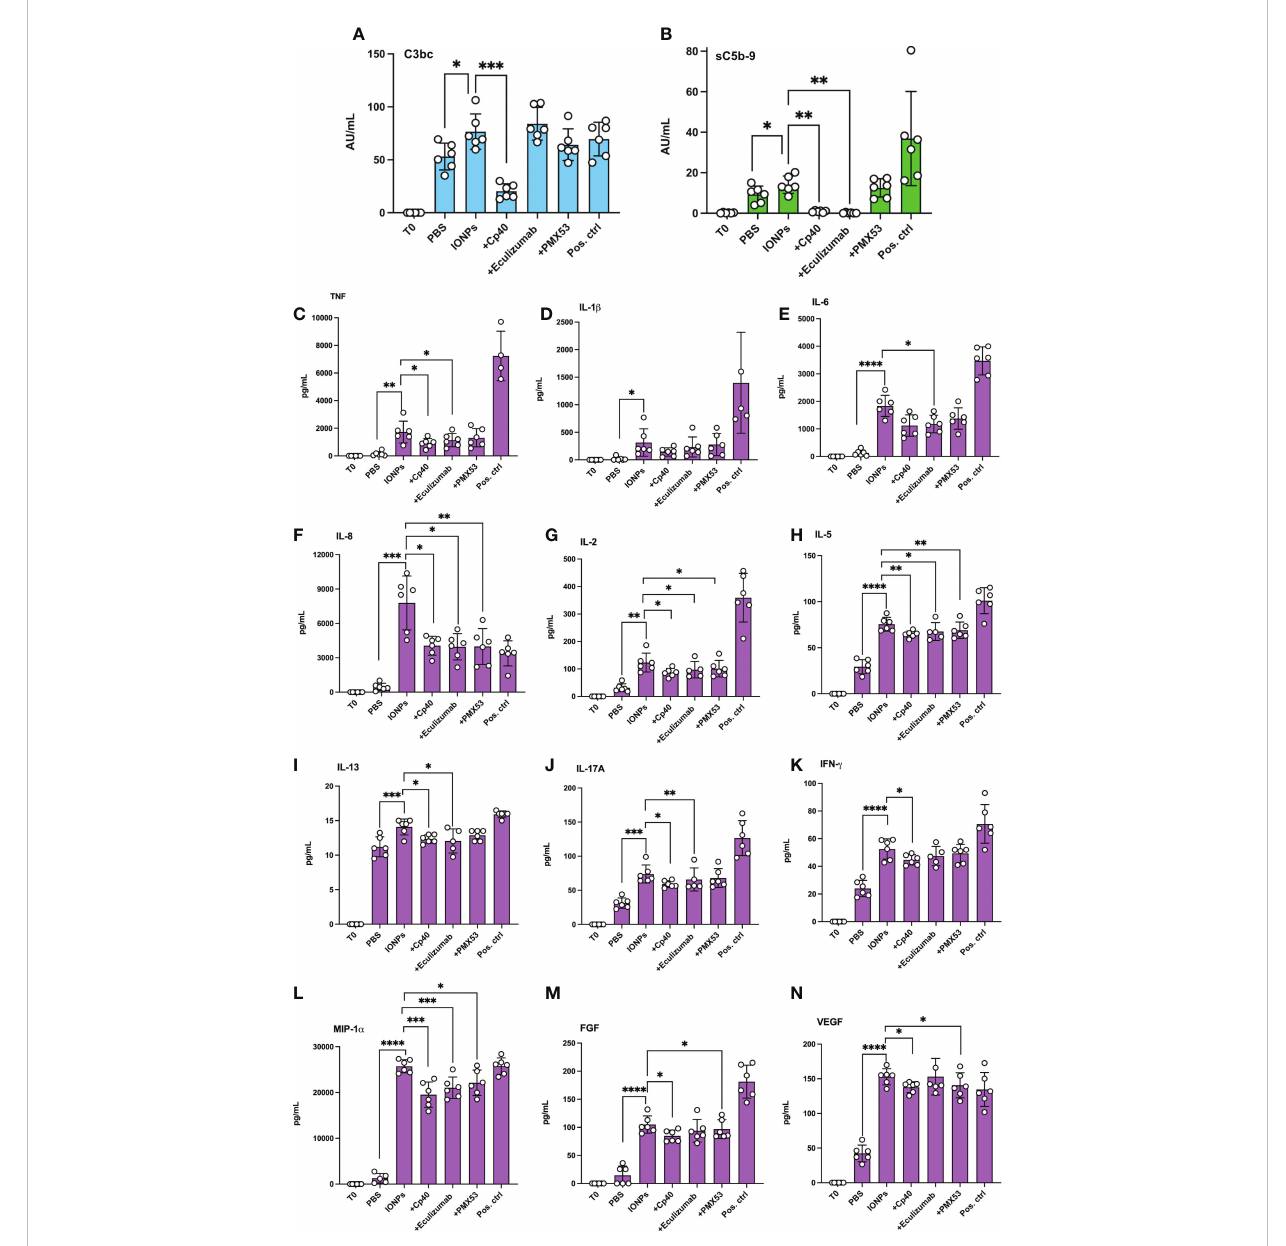
FIGURE 3 IONPs-induced complement activation and cytokine release in whole blood interplay with endothelial cells. Human whole blood was incubated together with HLMECs and a mixture of IONPs (100 m g/mL) of different sizes; 10, 20, and 30 nm in the presence of inhibitors; Cp40 (20 m